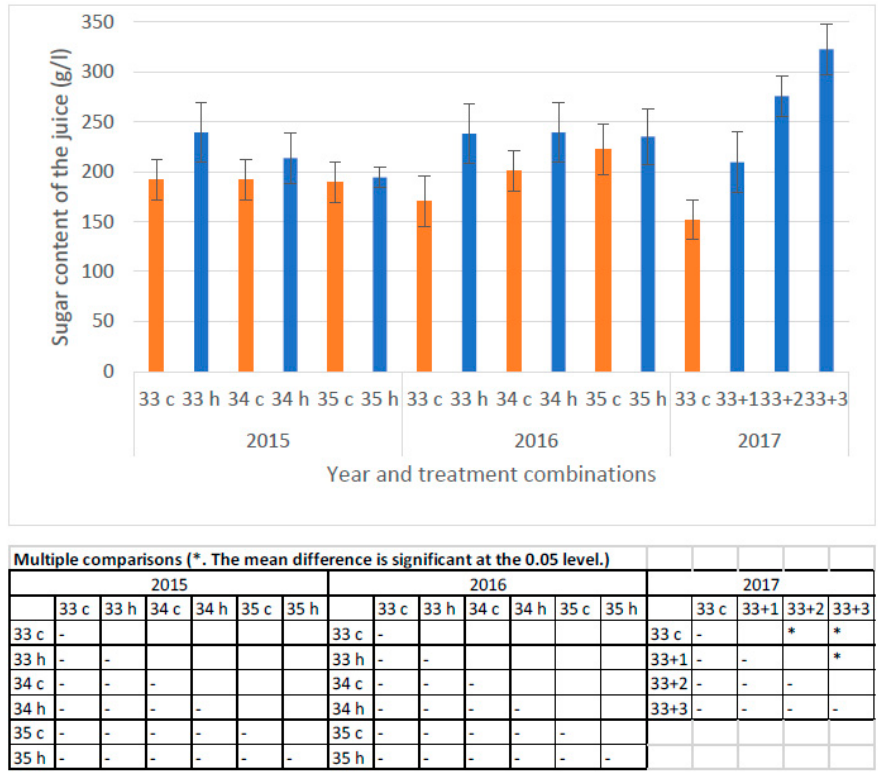
Figure 3. The effect of the different DMR treatments on the sugar content of the juice (g/L).